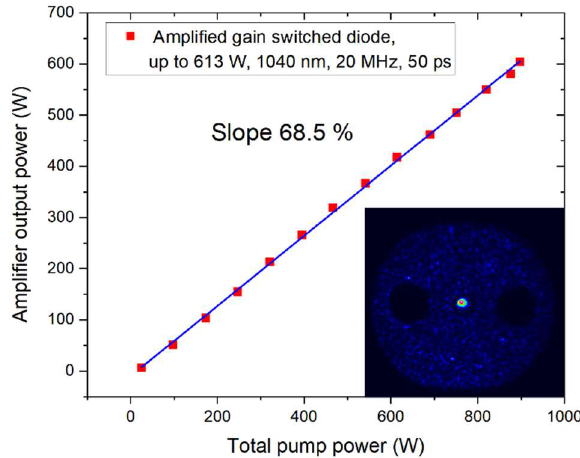
Fig.2. Output spectra of high power MOPA system at the maximum achieved power.Inset: the far-field beam profile and the fiber facet image.